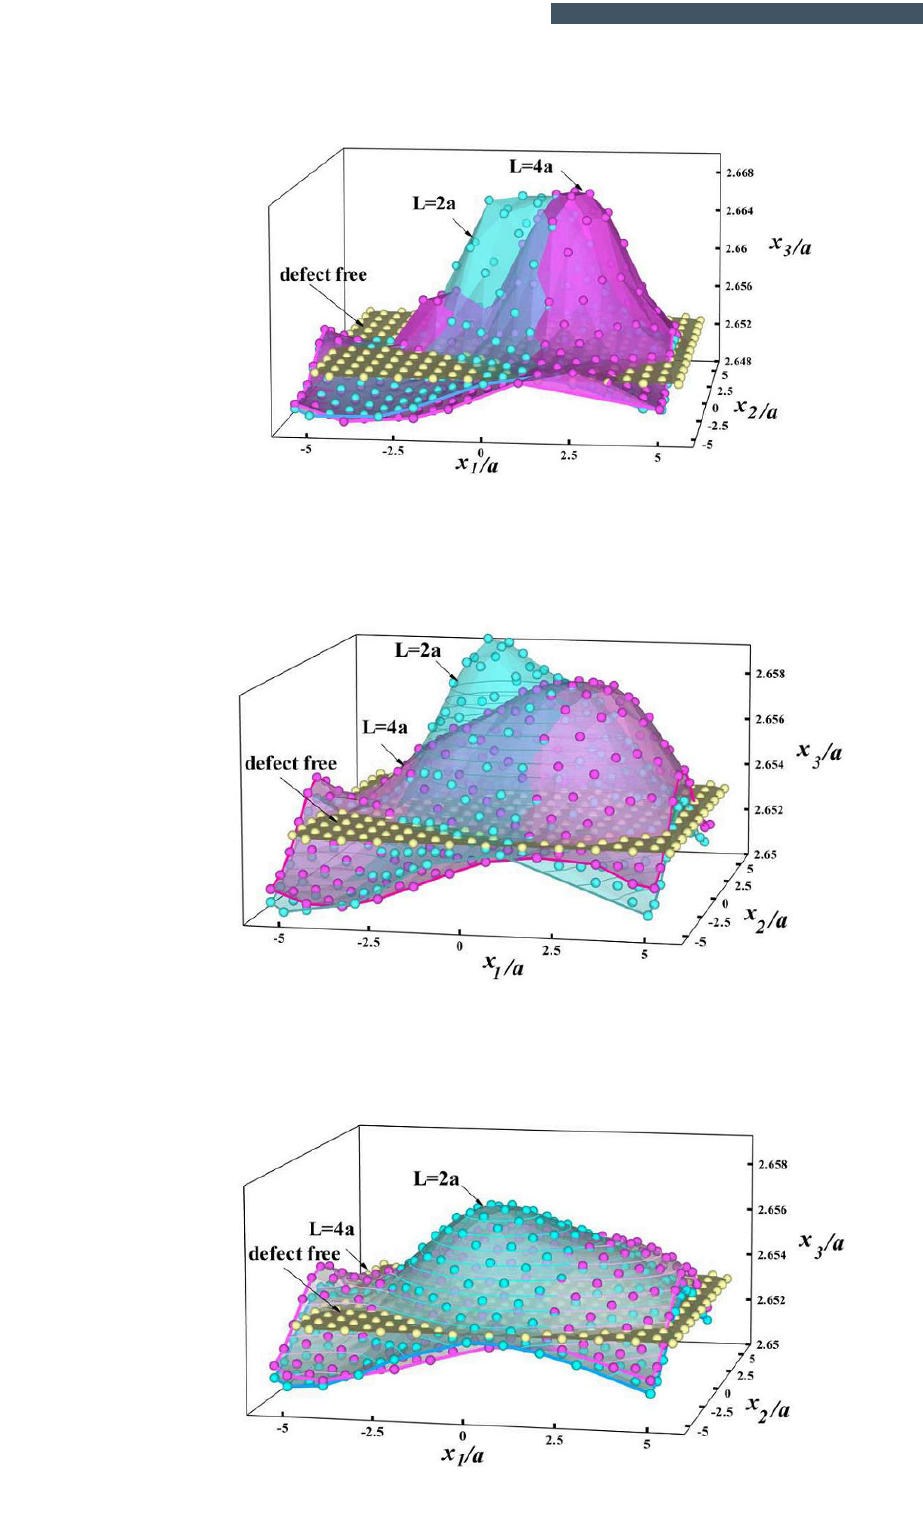
Figure 6. The free surface shape induced by a dopant-vacancy system with (a) D